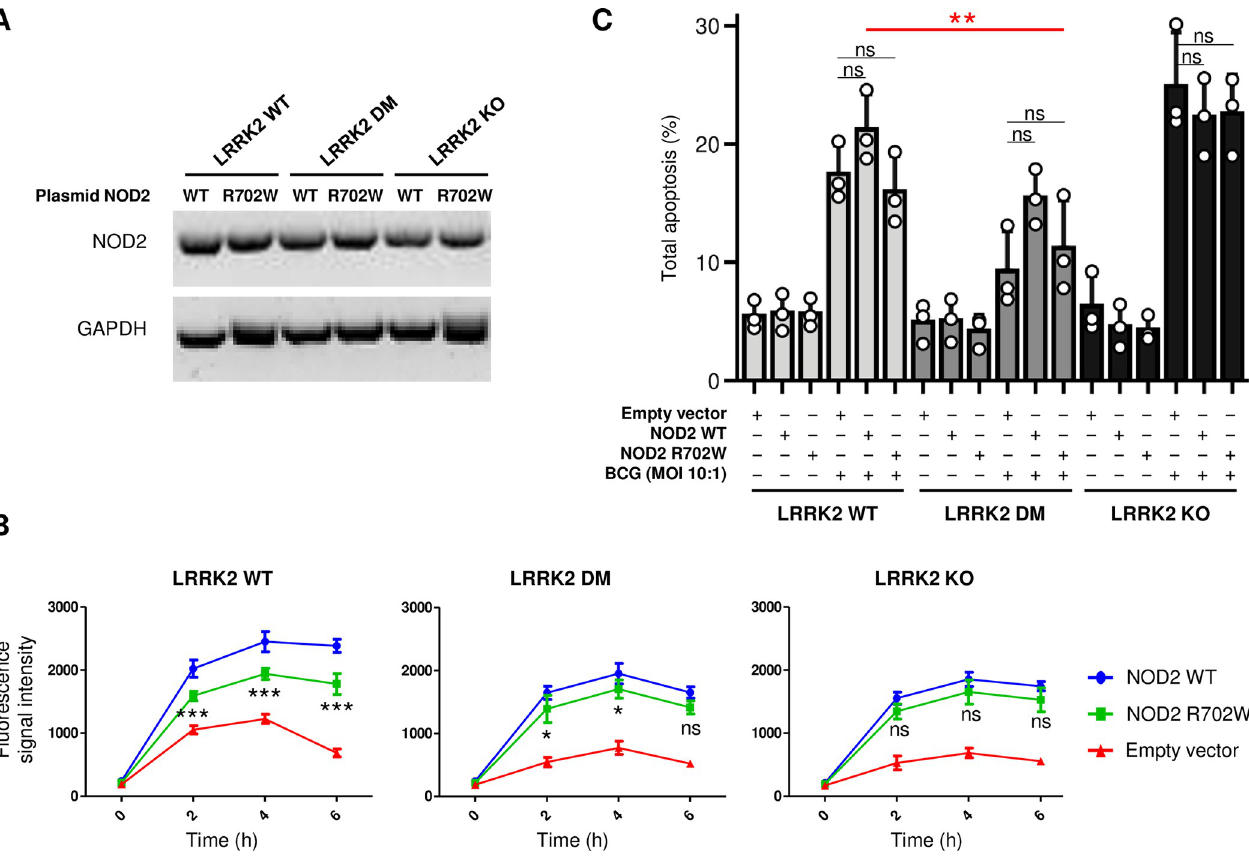
Fig 3. Effects of LRRK2 and NOD2 variants on respiratory burst and apoptosis in response to BCG infection. (A) RAW264.7 cells carrying LRRK2 WT, LRRK2 DM and no LRRK2 protein (KO) were transfected with plasmids expressing NOD2 WT or mutant NOD2 (R702W). One representative result of three independent experiments is shown. (B) Effect of NOD2 WT and R702W on reactive oxygen species (ROS) production after infection with BCG on the background of different LRRK2 genotypes. BCG-induced ROS production in cells transfected with NOD2 WT, NOD2 R702W or an empty plasmid are presented for cell lines with LRRK2 WT (Left panel), LRRK2 DM (middle panel) and LRRK2 KO (right panel). The graphs present one representative experiment (mean ± SD) of three independent experiments, each one done in triplicates. (C) Effect of LRRK2 and NOD2 variants on apoptosis in response to BCG. Percentage of total apoptotic cells, including cells with early and late apoptosis, was calculated in uninfected and BCG-infected cells, which is shown in the figure. The illustrated result presents one representative experiment (mean ± SD) of two independent experiments (done in triplicates). Significance of difference between LRRK2 WT+NOD2 WT and the genotype carried by the early onset leprosy twins (LRRK2 DM+NOD2 R702W) is indicated in red. B-C *** P < 0.001; ** 0.001 � P < 0.01; * 0.01 � P < 0.05; ns: non-significant. BCG: Bacillus Calmette–Gue´rin; DM: double-mutant; KO: knock-out; WT: Wild-